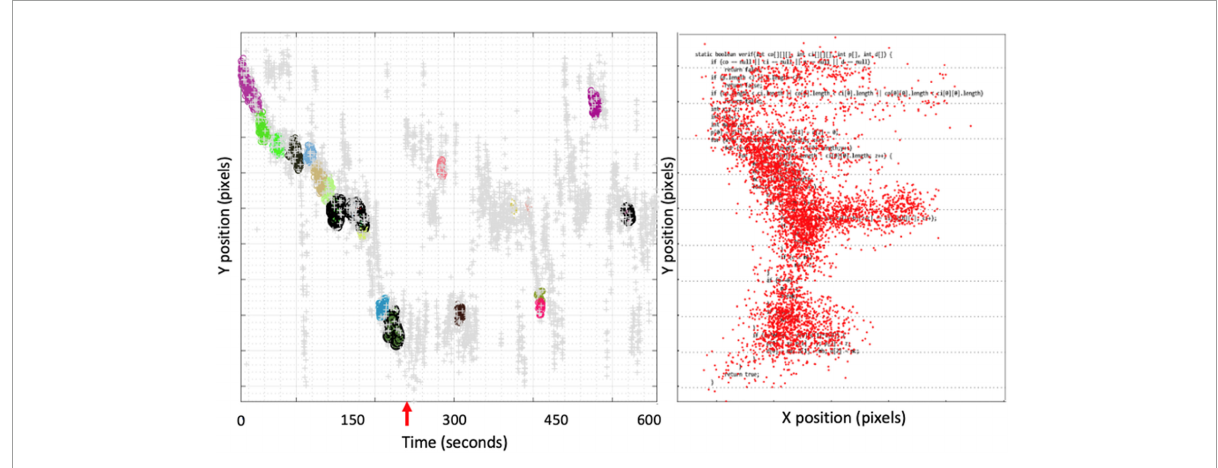
FIGURE4 Eye tracker data for Participant 2 in the comprehension task for program